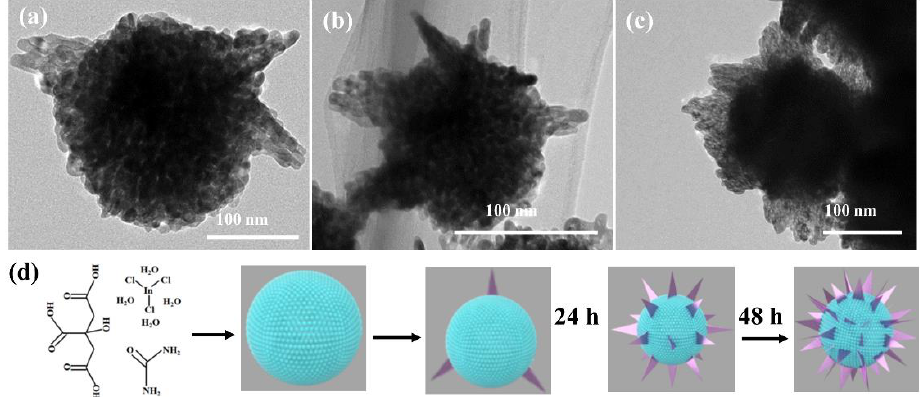
Figure 3. ( a – c ) FESEM images of the samples at various reaction times: ( a ) 18 h, ( b ) 24 h and ( c ) 48 h; ( d ) schematic of the growth process of the porous In 2 O 3 nanostructures at various reaction times. The specific surface areas of 18-In 2 O 3 , 24-In 2 O 3 and 48-In 2 O 3 samples were estimated